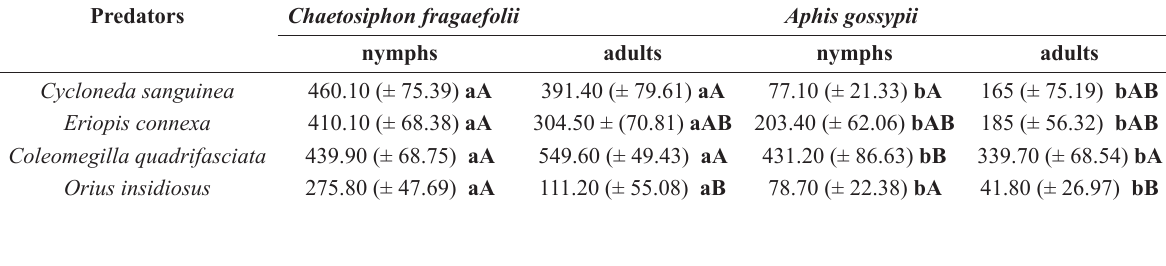
Time (seconds) to the fi rst attack by diff erent predator species in presence of aphids species. The data correspond to the means ± the standard error.